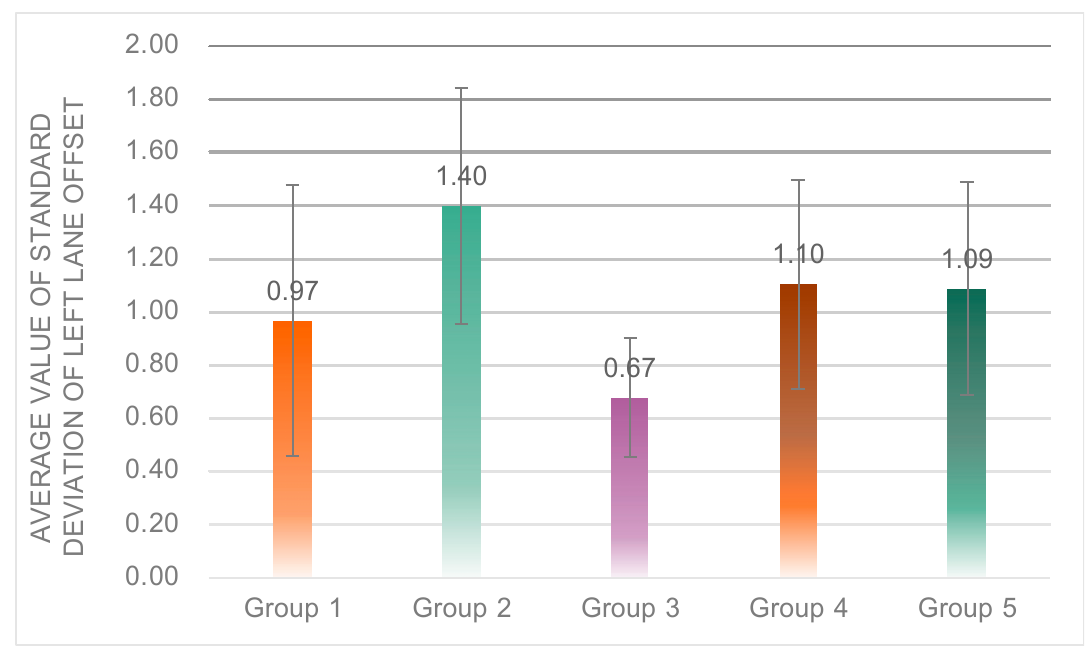
Figure 13. Average value of standard deviation of left lane offset of the five groups.